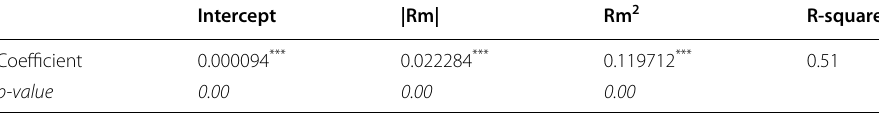
The table shows the estimates of the following model: CSAD t = γ 0 + γ 1 | Rm t | + γ 2 Rm 2 t + ε t Estimation includes five lags of CSAD. Results using Newey–West heteroscedasticity and autocorrelation consistent estimators. *** , ** , * indicate significance at 1%, 5% and 10% respectively.